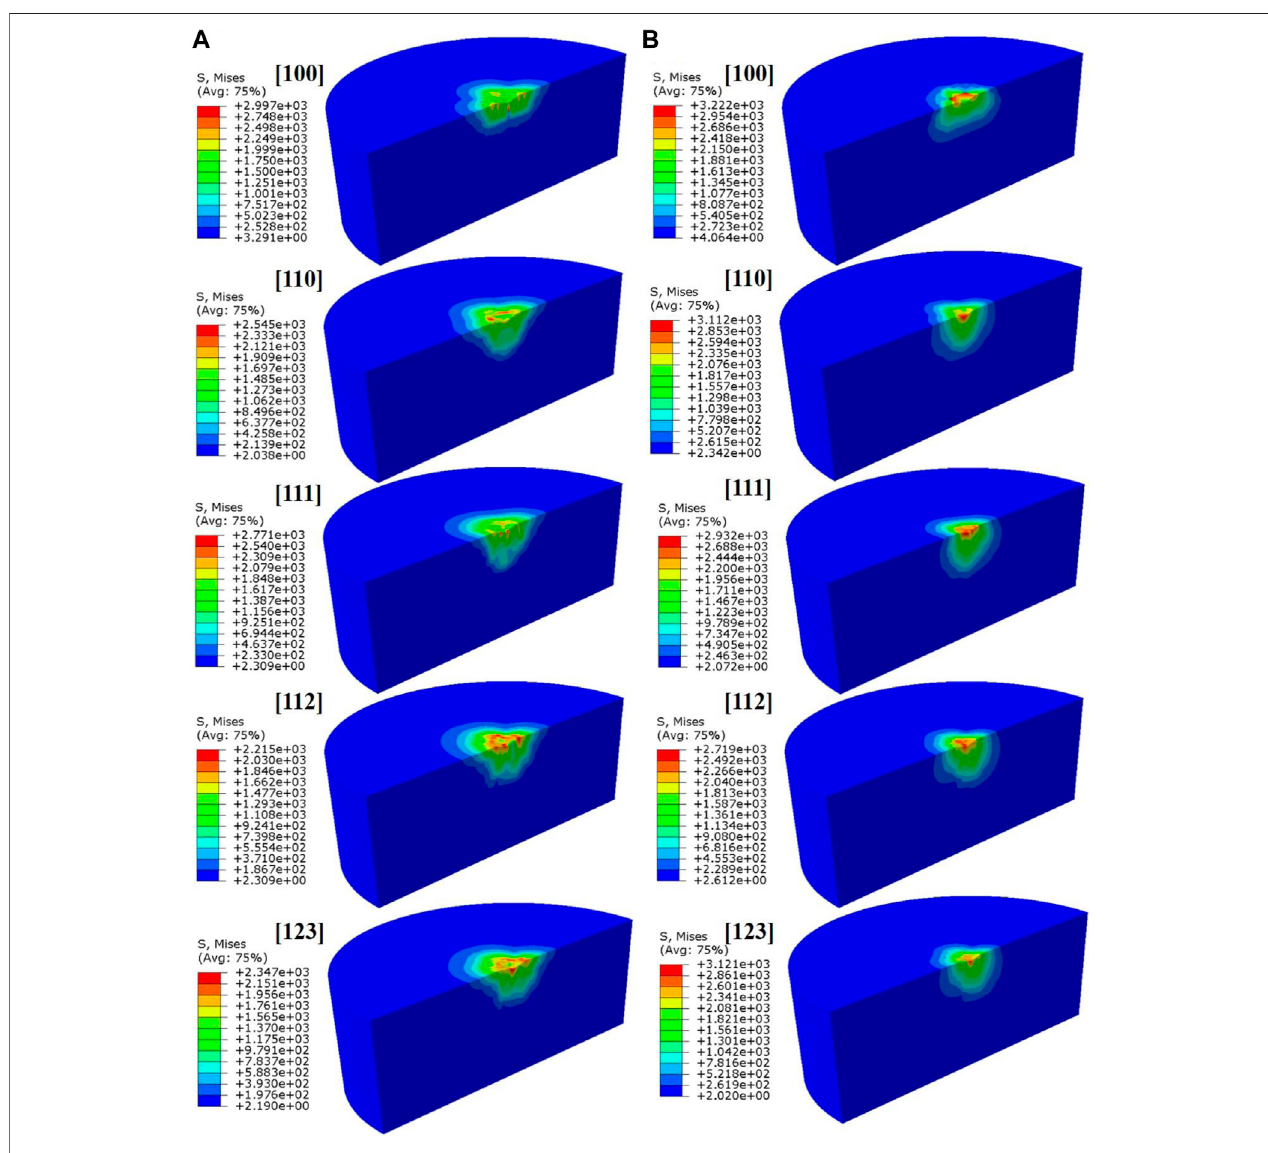
FIGURE 13 | Mises stress contours with a dose of 2.85 dpa at (A) 20 ° C and (B) 300 ° C.